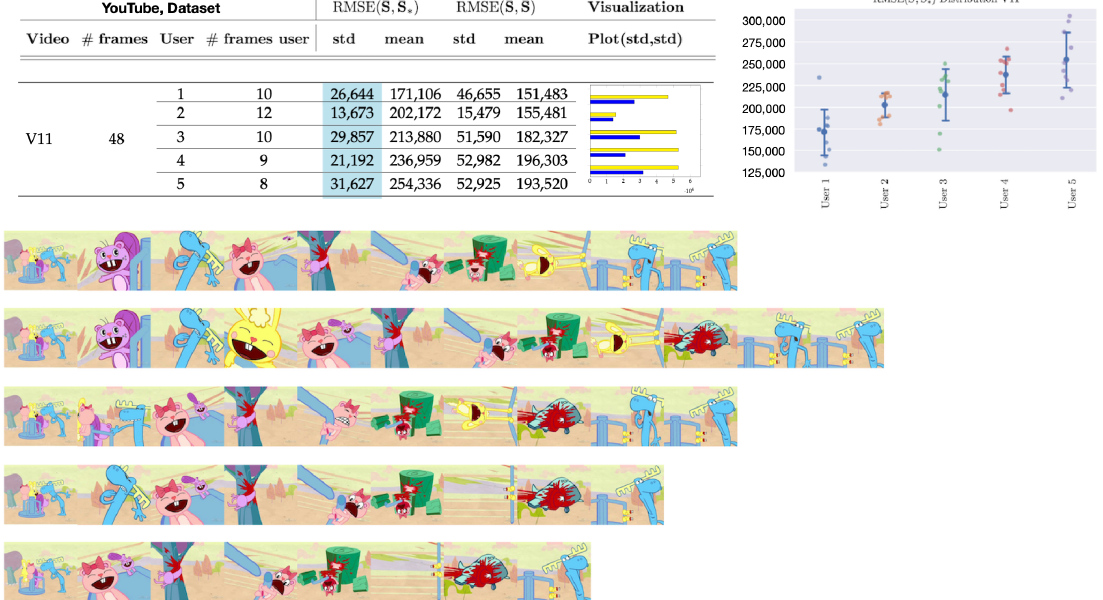
Figure 8. Visual depiction of human annotated summaries together with RMSE ( ¯ S , ¯ S RMSE ( ¯ S , ¯ S ) of video V11, Table 3. Sampling rate: 1 frame per second. Highlighted values on